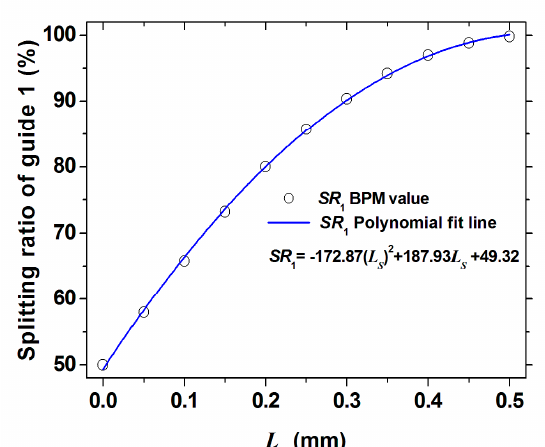
Figure 3. The splitting ratio variations of output port guide 1, as the function of shifting length L s at wavelength 1.55 µm. The second order polynomial curves of splitting ratio of guide 1 is demonstrated.